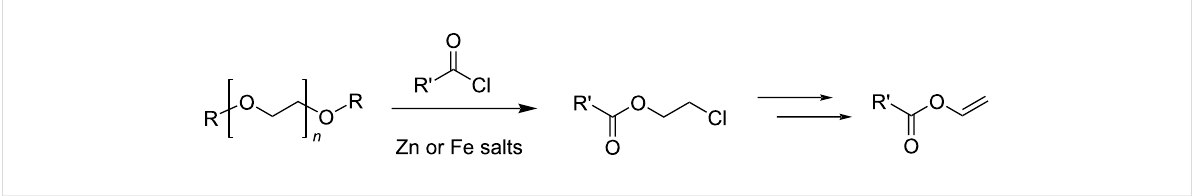
Scheme 24: Depolymerisation of polyethers with metal salt catalysts and acyl chlorides.